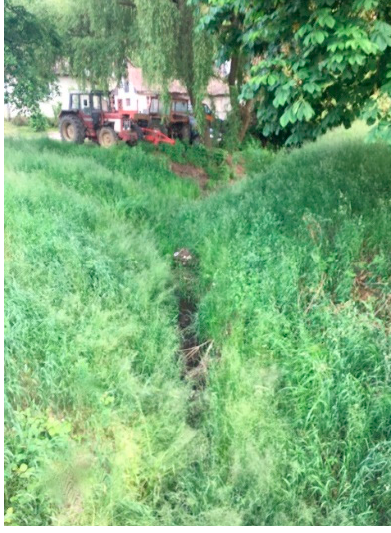
Figure 4. Dupu ş River non-refuge sector. Figure 4. Dupu¸s River non-refuge sector.